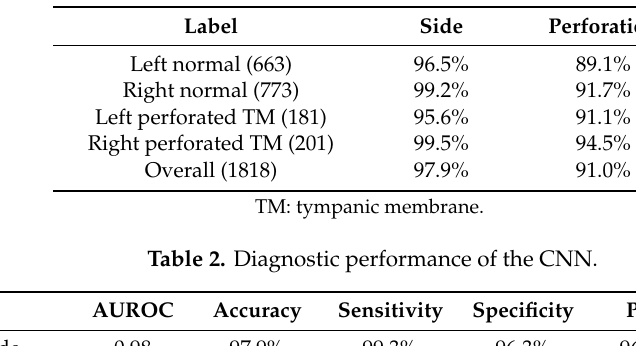
Table 1. Test phase accuracy.